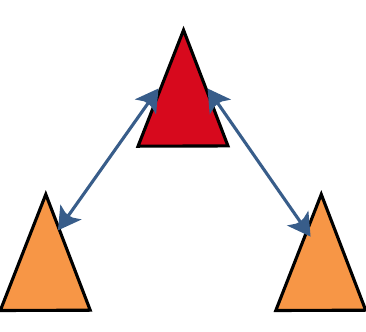
Figure 1. Communication graph for